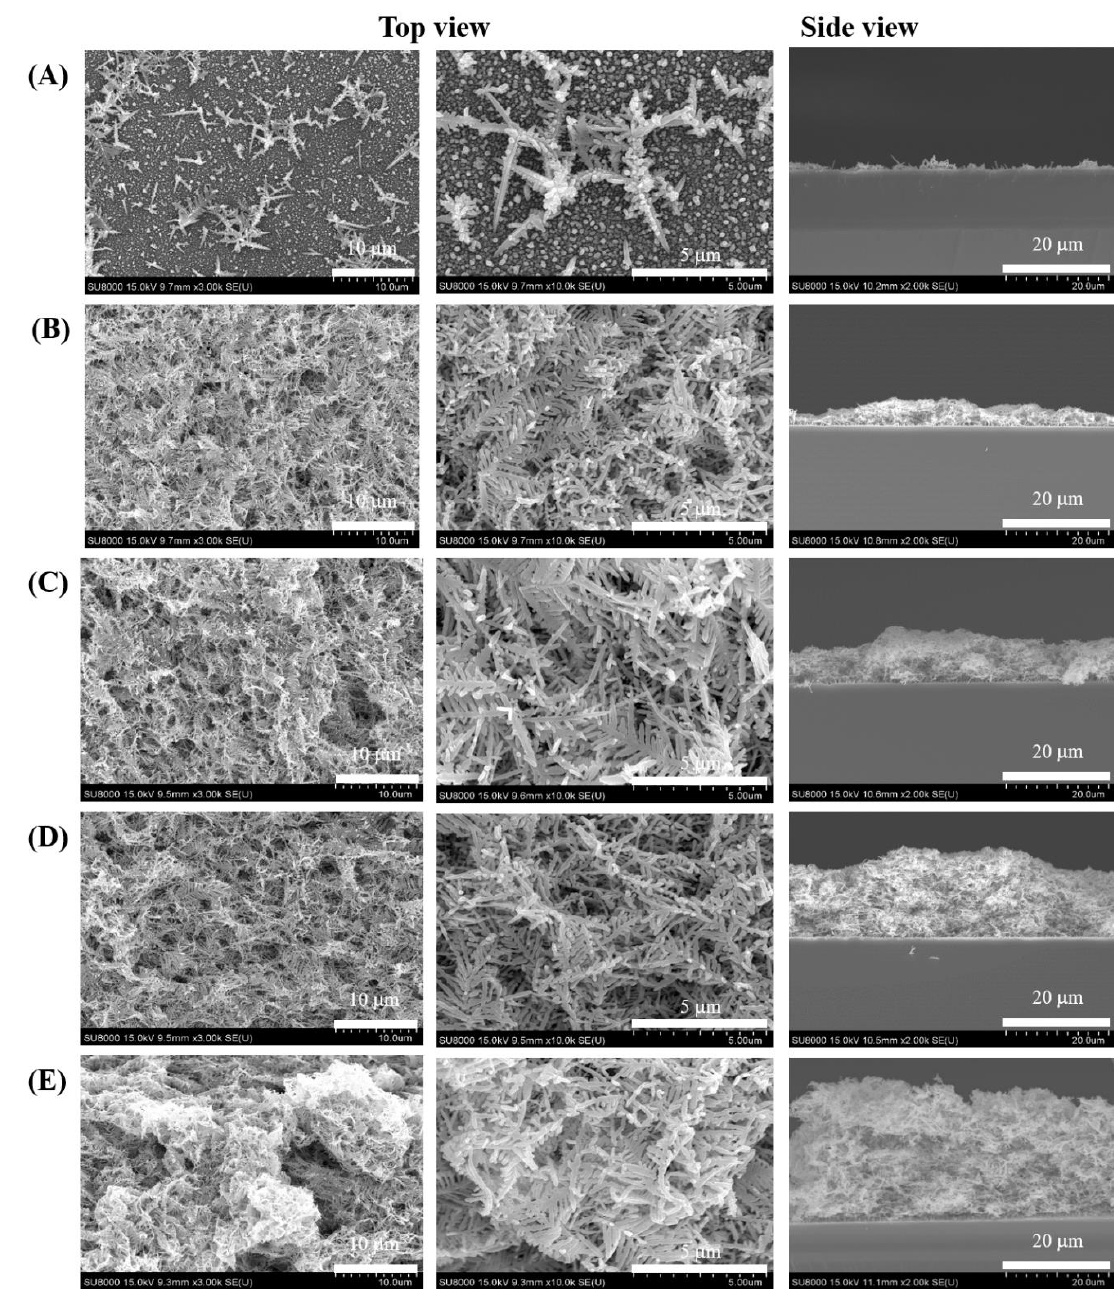
Figure 4. Representative SEM images of the Ag nanostructures prepared at various Ag + ion concentrations: ( A ) 0.02, ( B ) 0.04, ( C ) 0.06, ( D ) 0.08, and ( E ) 0.10 M. Scale bar: 10 µm, 5 µm (top view) and 20 µm (side view).